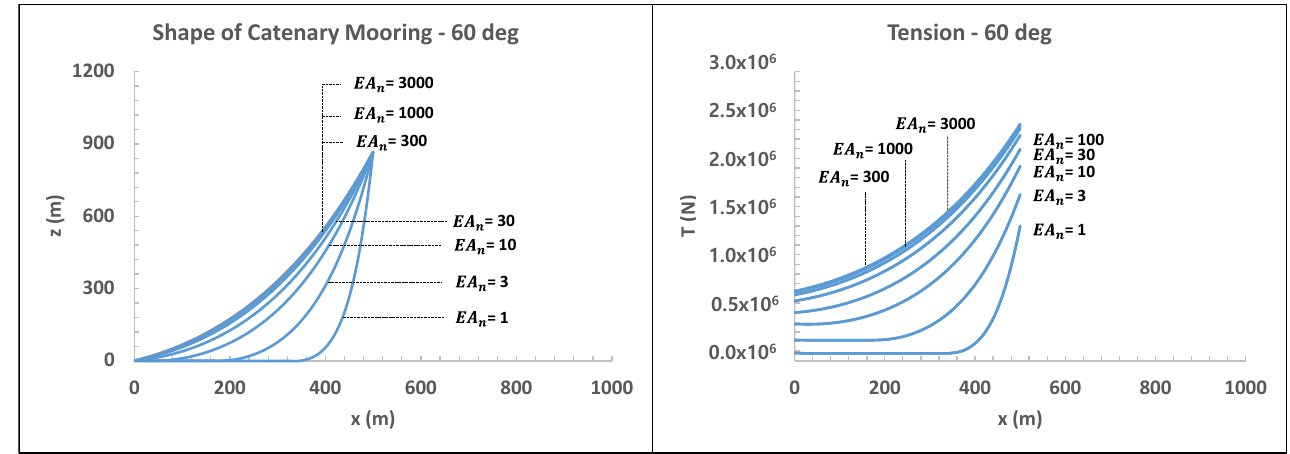
Figure 12. Conditions of the first simulation for forced oscillation body with two mooring lines.